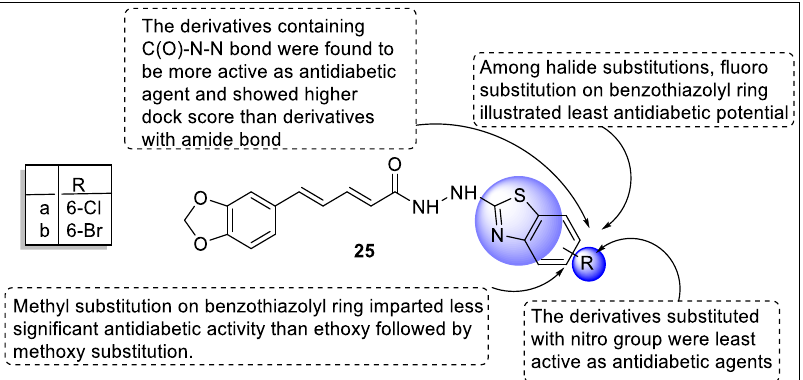
Figure 29. Structural activity relationship of thiazole hybrids ( 25 ) as potent PPAR ligands. Li et al. designed some hybrid compounds of AM-4668, CP-1 (FFA1 agonist), and GW501516 (selective PPARδ agonist) as dual agonists of FFA1 and PPARδ in the treat- ment of several metabolic disorders. The potential of hybrid analogs was screened on the FFA1 and PPARδ receptors using Chinese hamster ovary cells and Gal4 receptor cell - based assay, respectively. Analog 26 was identified as an orally bioavailable agonist of FFA1 and PPARδ with EC 50 values of 68 nM and 102 nM, respectively, which also showed selectivity toward PPARs. Along with selectivity and potency, analog 26 displayed a good pharmacokinetic profile with good plasma exposure and decreased glucose level. The docking studies revealed that analog 26 showed H-bonding interaction with His449, Tyr473, and His323 with the help of carboxylic acid as a scaffold. Moreover, the hydro- phobic pocket (Ile249, Leu255, and Ala258) of PPAR δ was well attached to the trifluoro- methyl group of left benzene (Figure 30) [101]. Figure 30. Structural activity relationship of thiazole hybrids ( 26 ) as potent PPAR ligands. Ammazzalorso et al. designed a series of benzothiazole derivatives to antagonise the activation of PPARs. The activity of the synthesized analogs was investigated on the hu- man PPARs through transactivation assay using Wy-14,643, L-165,041, and rosiglitazone as reference s for PPARα - δ - γ , respectively. The study revealed that analogs 27a – g exhib- ited inactivity for activation of PPARα - δ - γ. Thus , researchers investigated the antagonist potential of analogs via a competitive binding assay that resulted in analogs 27a – g selec- tively antagonized PPARα with a 22– 57% range of inhibition. Analogs 27d – g containing bulkier group at amide displayed better antagonistic activity toward PPARα and all syn- thesized analogs were comparatively inactive towards PPARδ - γ (Figure 31). The anti-pro- liferative action of synthesized analogs was explored using various tumor cells such as AsPC-1 and Capan-2 for pancreatic, HT-29 and SW480 for colorectal, along with PTJ64i and PTJ86i for paraganglioma cancer cell lines. With regard to referencing PPARα agonist